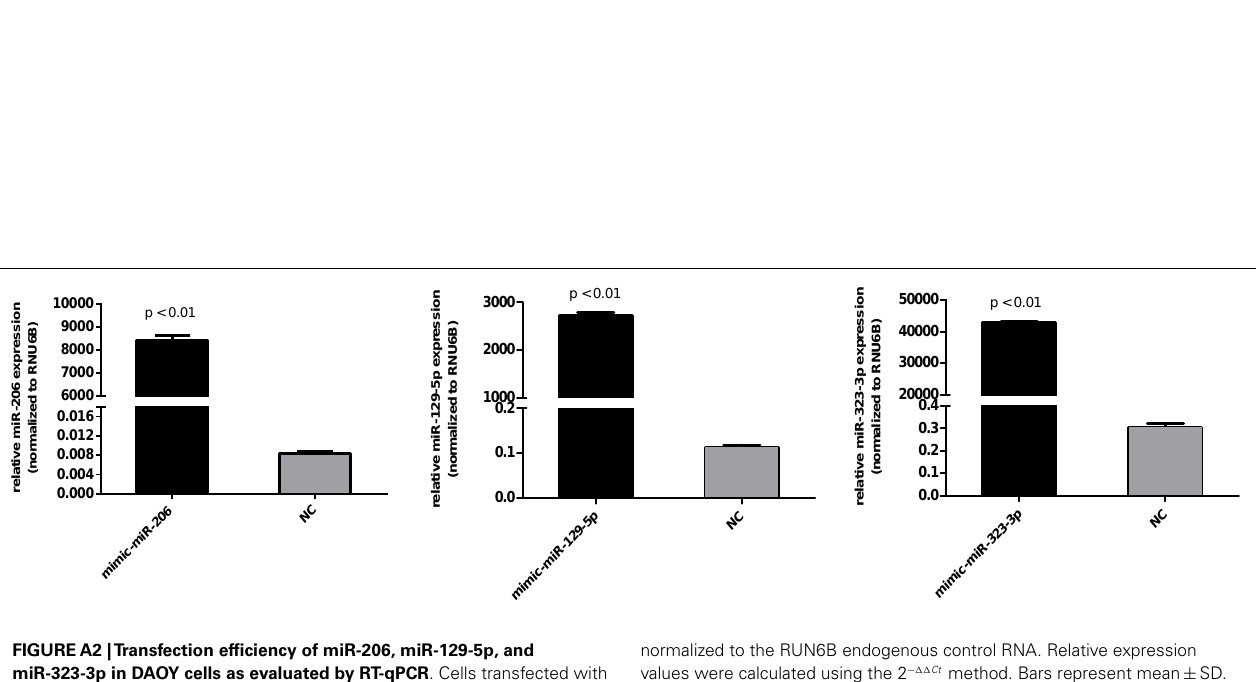
using the SYBR method. Primers are available upon request to the authors.Values were normalized to the HPRT endogenous control gene. Relative expression values were calculated using the 2 − ∆∆ Ct method.